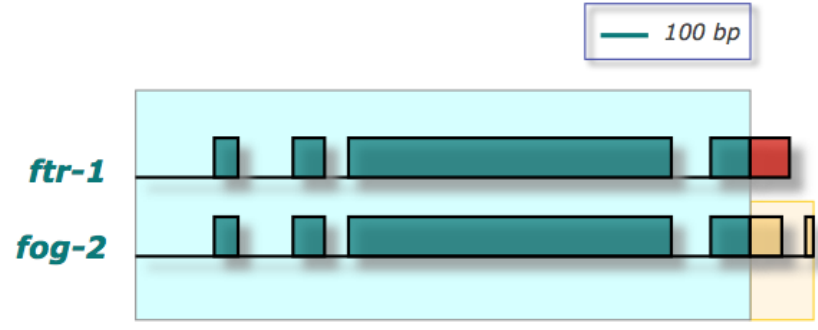
Figure 2. Schematic depicting the regions of homology between the paralogs fog-2 and ftr-1 [39,47]. Shaded rectangles denote exons; horizontal lines represent introns and duplicated flanking regions where applicable. The duplicated region is shaded in light blue. Duplicated segments as determined by sequence homology between the two paralogs are also depicted by the correspondence of regions with identical color and pattern.